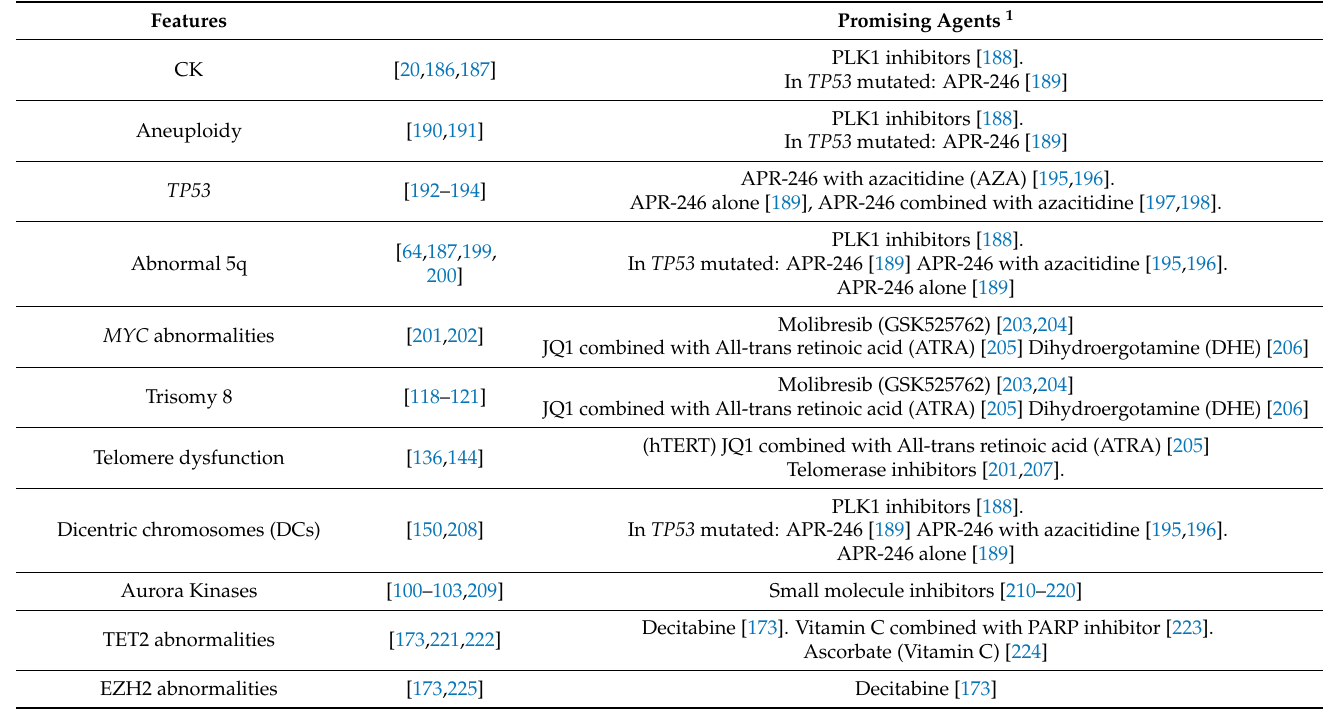
Table 1. CIN features during AML course and drugs used in preclinical and clinical studies. Features